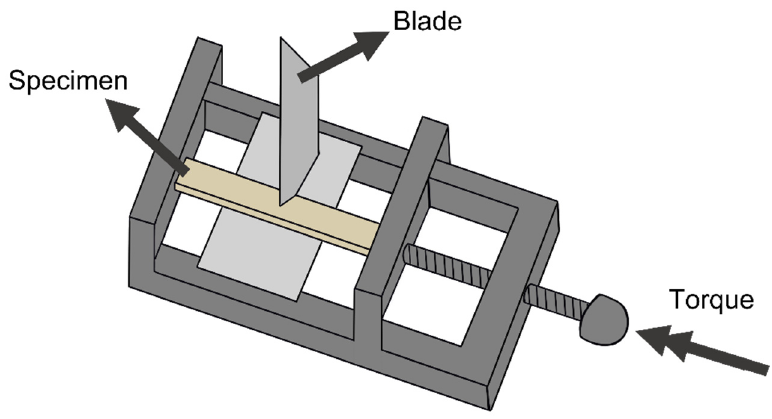
Figure 1. Schematic representation of the device used for the thermal mending